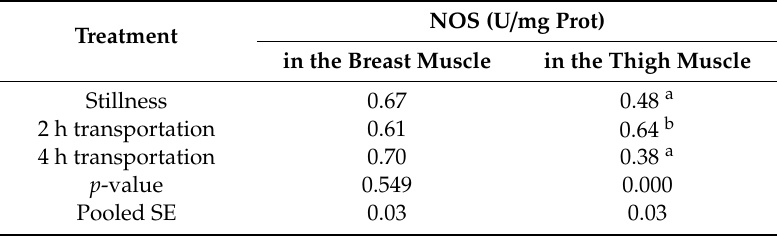
Figure 2. E ff ect of di ff erent transportation treatments on activities of GSH and SOD enzymes from Figure 2. Effect of different transportation treatments on activities of GSH and SOD enzymes from breast and thigh muscle of broilers. Bars within a cluster with di ff erent superscripts di ff er ( p < 0.05). breast and thigh muscle of broilers. Bars within a cluster with different superscripts differ ( p < 0.05). GSH = glutathione peroxidase, and SOD = superoxide dismutase. GSH = glutathione peroxidase, and SOD = superoxide dismutase. Table 4. E ff ect of di ff erent transportation treatments on nitric oxide synthase (NOS) activity in Table 4. Effect of different transportation treatments on nitric oxide synthase (NOS) activity in broiler broiler muscle.